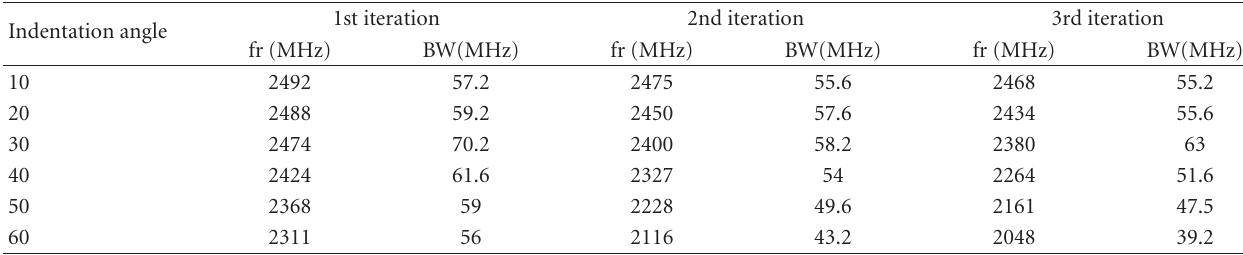
Table 1: Resonant frequency and bandwidth of proposed antennas.